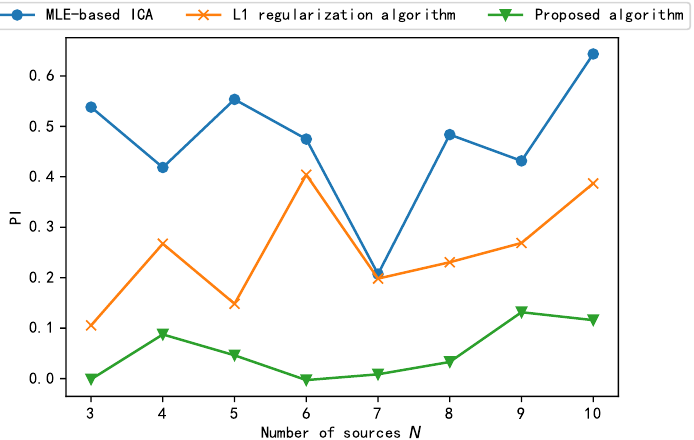
Figure 11. Separation performance of proposed algorithm and comparison algorithm under different number of sources.